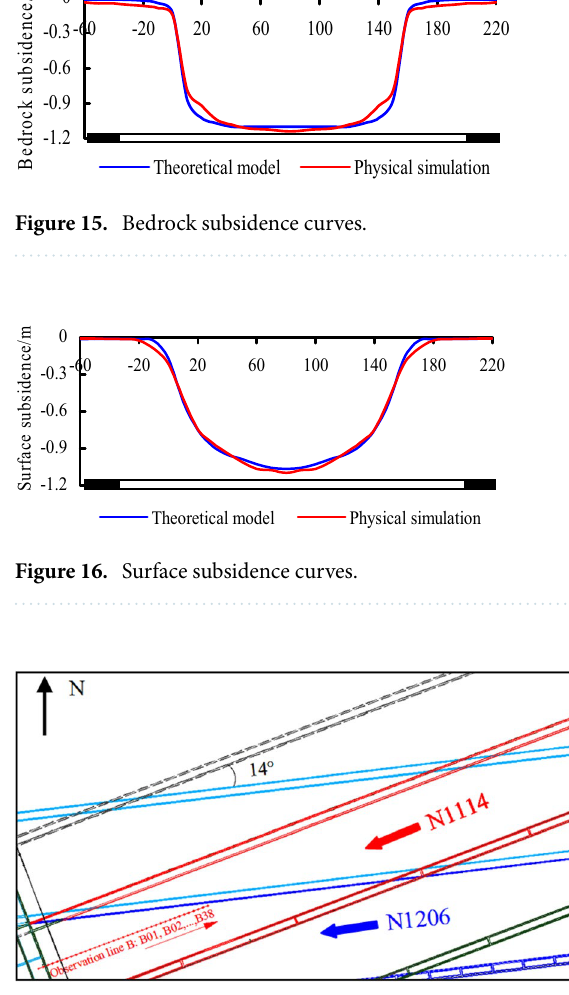
Figure 17. The arrangement of the observation line B.